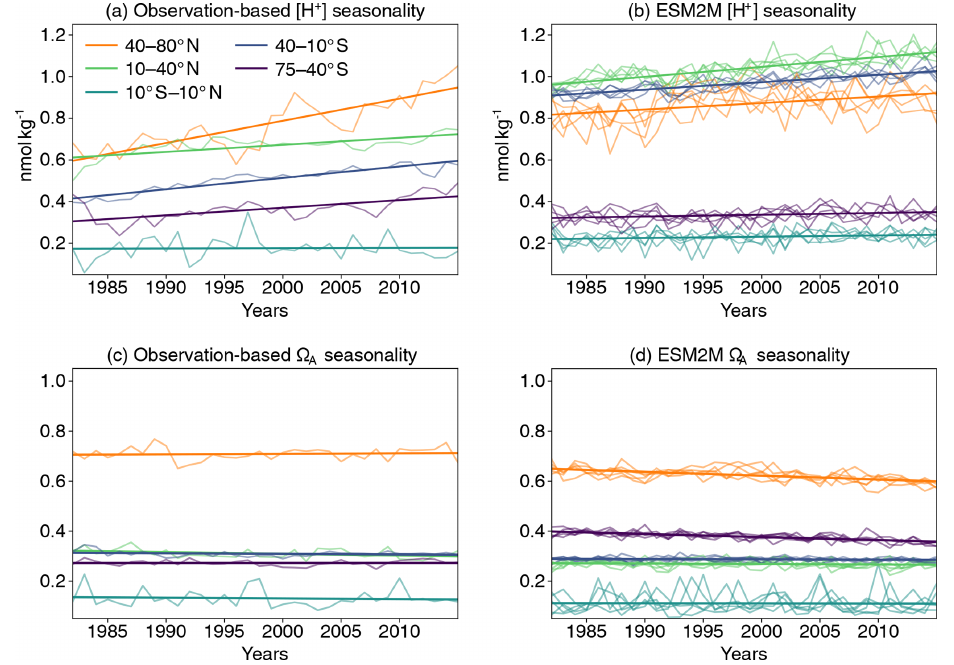
Figure 3. Seasonal amplitude of [H + ] (calculated as yearly maximum minus the yearly minimum after subtracting a cubic spline from the data) over the period 1982–2015 averaged over five different latitude bands for the observation-based estimate (a) and the GFDL ESM2M model historical (1982–2005) and RCP8.5 (2006–2015) ensemble simulations (b) , along with the same for data-based (cid:127) A (c) and simulated (cid:127) A (d) . Linear trends in all panels are overlaid as thick lines. The linear trend of the simulated changes is calculated as the mean of the five individual ensemble trends. Table 1. Linear trends in seasonal amplitude of [H + ] (in nmolkg − 1 per decade) and (cid:127) A (in 10 − 3 per decade) for five latitude bands over the period 1982–2015. Results are shown for the observation-based data (Obs.) and the five-member ensemble mean of the ESM2M model simulations (ESM2M) following the RCP8.5 scenario over 2006–2015. The range ( ± ) denotes the 90% confidence interval. Latitude Obs. [H + ] ESM2M [H + ] Obs. (cid:127) A ESM2M (cid:127)